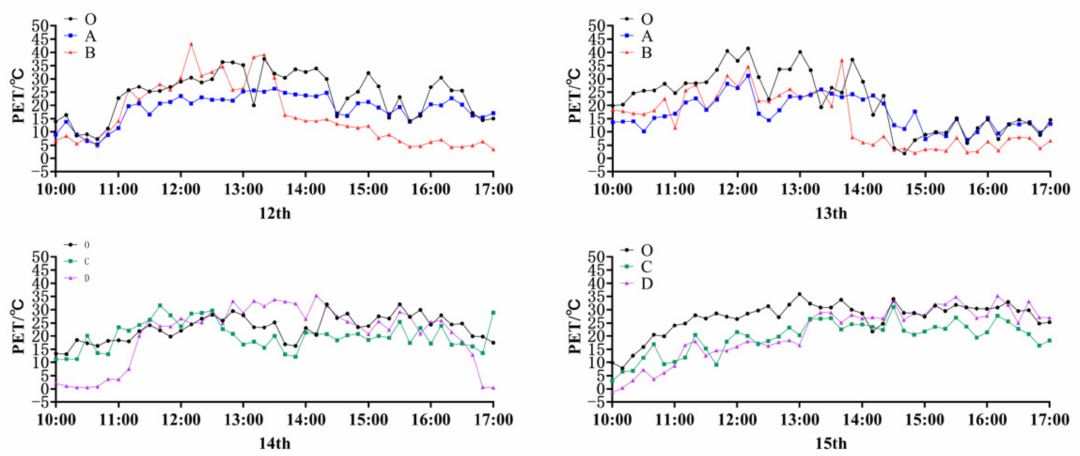
Figure 11. Comparison of PET changes in different